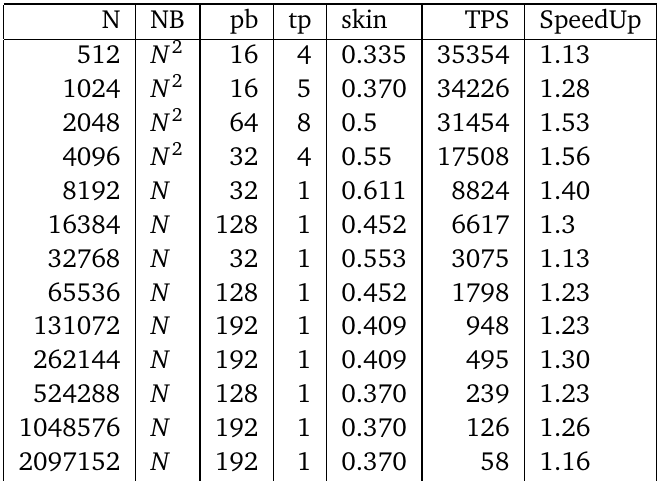
Table 3: Performance parameters chosen by the autotuner and the resulting TPS (Timesteps Per Second) on a Gtx1080 card (8.2 TFlops sp, 320GB / s). Last column is speed-up compared to the Gtx 780Ti card (Table